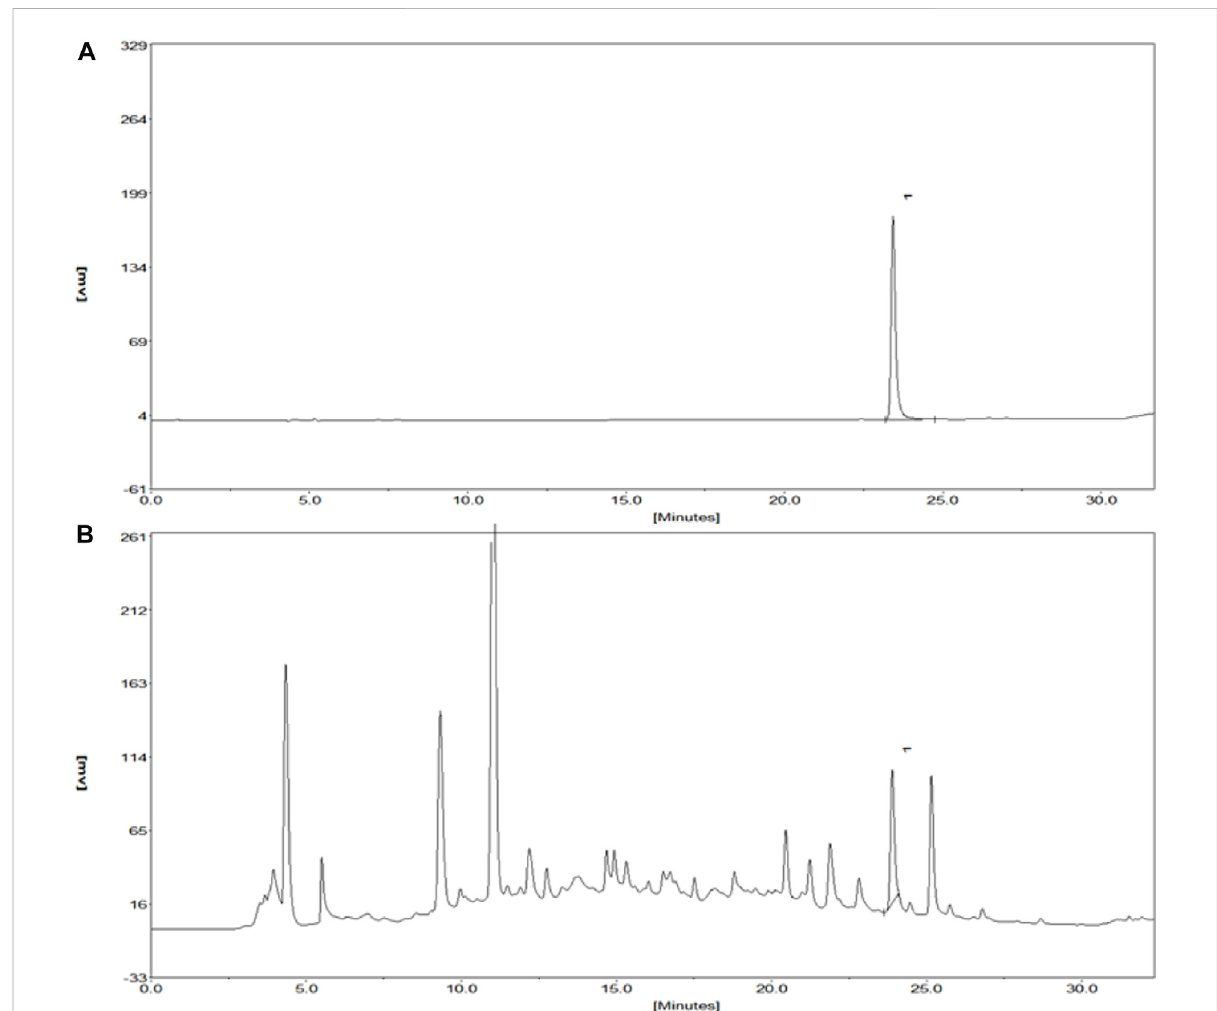
FIGURE 1 Chromatograms of the Salvianolic acid B standard and extract of KXF. (A) . Chromatogram of the Salvianolic acid B standard at 286 nm. The retention time of the Salvianolic acid B standard was 23.42 min, and the peak height and peak area of which were 178.11 and 1785.6 mV*sec, respectively. (B). Chromatogram of the extract of KXF at 286 nm. (1). Salvianolic acid